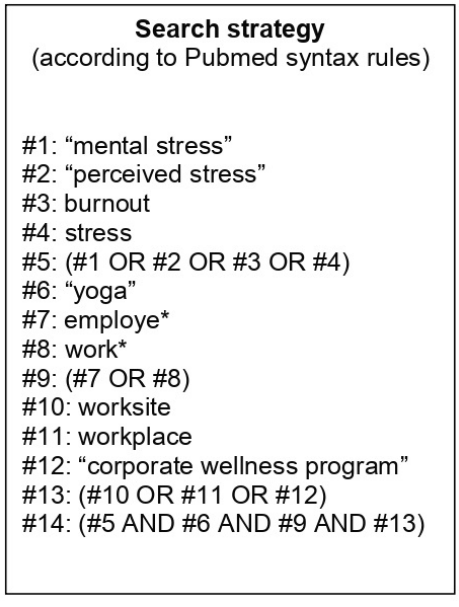
Figure 1. Detailed search strategy for Pubmed.